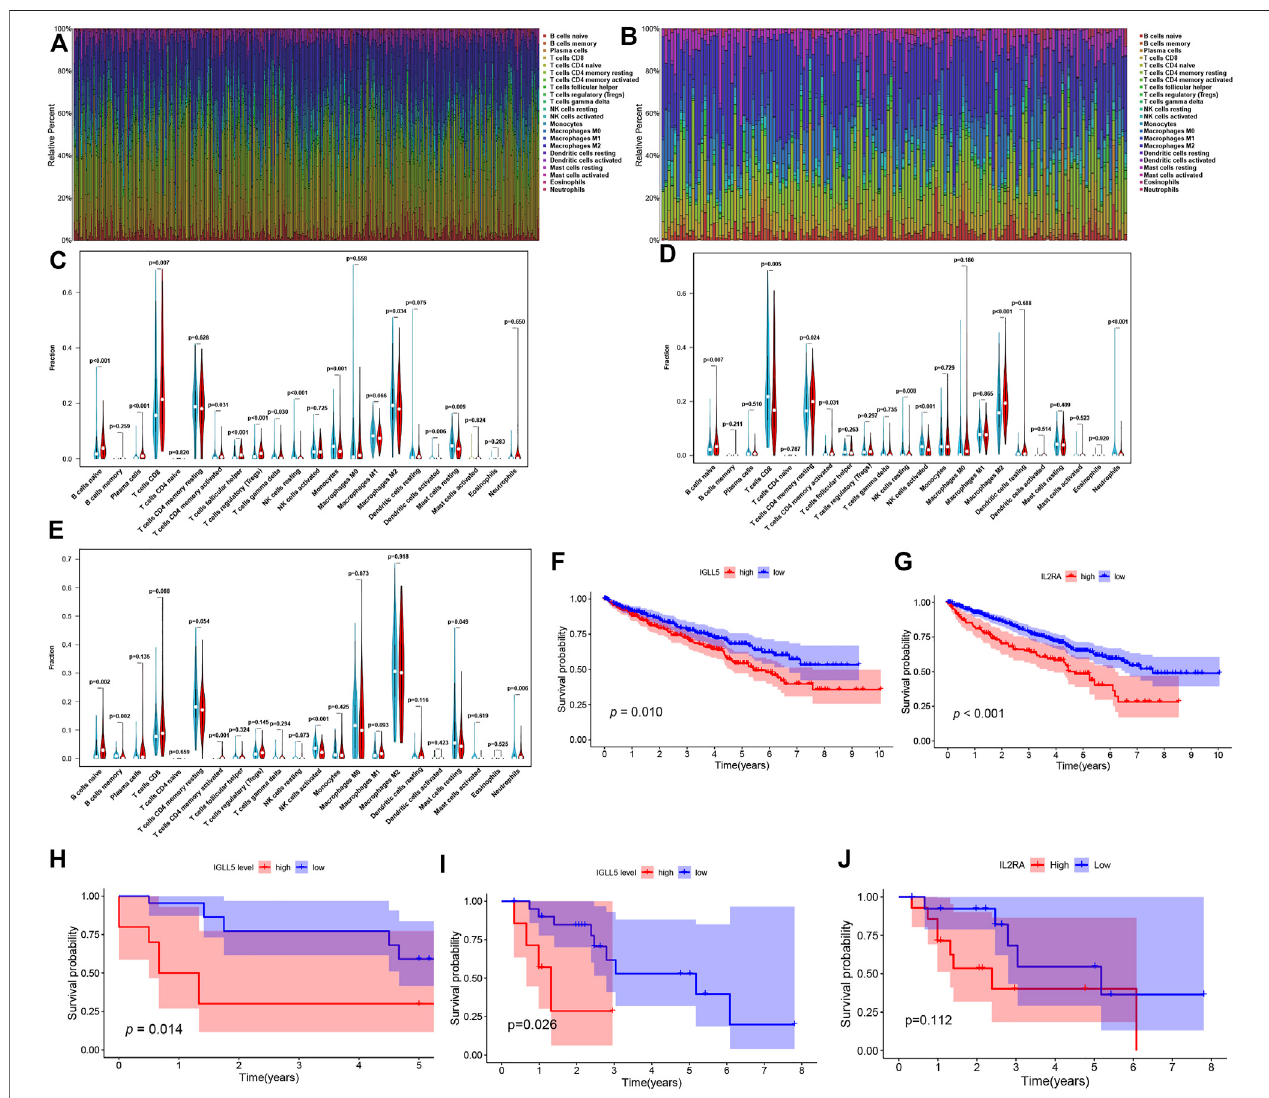
FIGURE5| Compositionofimmunecellsandcorrelationanalysis. (A,B) landscapeofthe22ImmunecellinccRCC (A) andpRCC (B) . (C-E) Differencesofimmune cells in fi ltration in ccRCC (C,D) and pRCC (E) . (F-I) Validation of IGLL5 and IL2RA in ICGC cohort (F-G) , GSE40912 (H) and GSE2748 (I-J) .